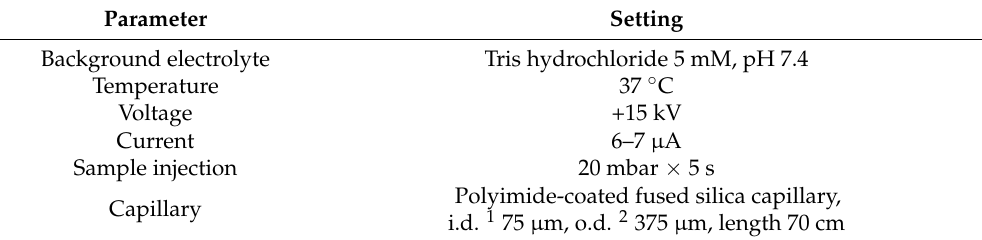
Table 2. CE optimized operational